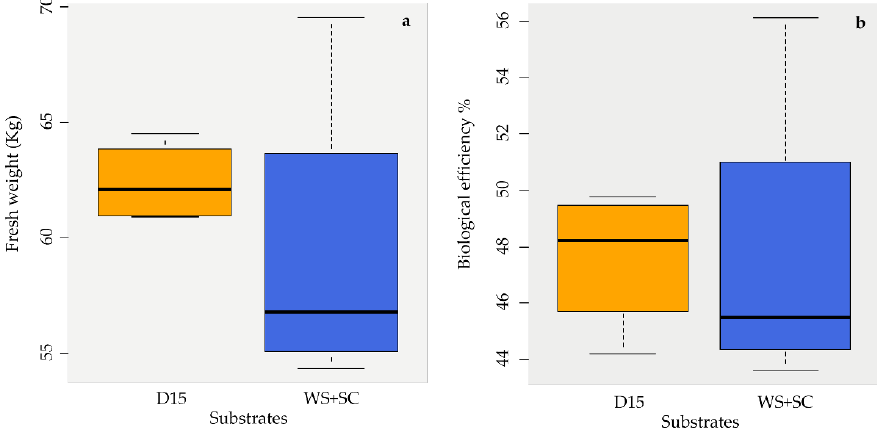
Figure 5. Fresh weight ( a ) and BE ( b ) of P. ostreatus grown on D15 (orange) and WS + SC (blue). A nother parameter evaluated was P during the first and second flushes. Again, as can be seen from Table 2, we found no statistical differences between D15 and the control.